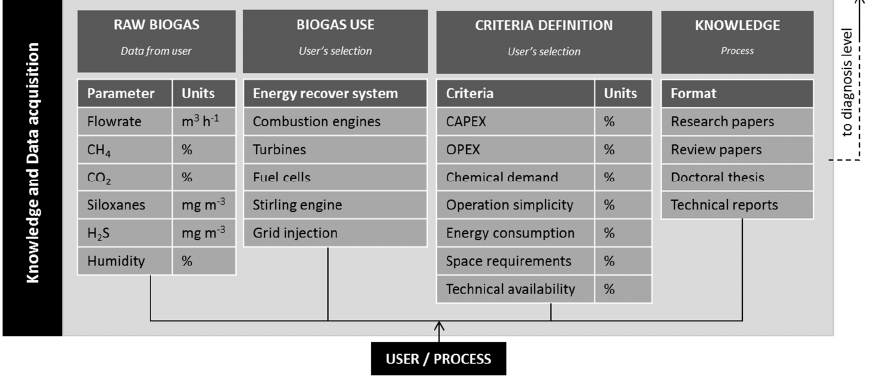
Figure 1. Scheme diagram of knowledge and data acquisition level. CAPEX: capital expenses; OPEX: operating expenses. Table 1. Concentration limits of each compounds according to quality requirements of different energy conversion systems [13,16,22,42,43]. ICE: internal combustion engine; PAFC: phosphoric acid fuel cell; SOFC: solid oxide fuel cell.